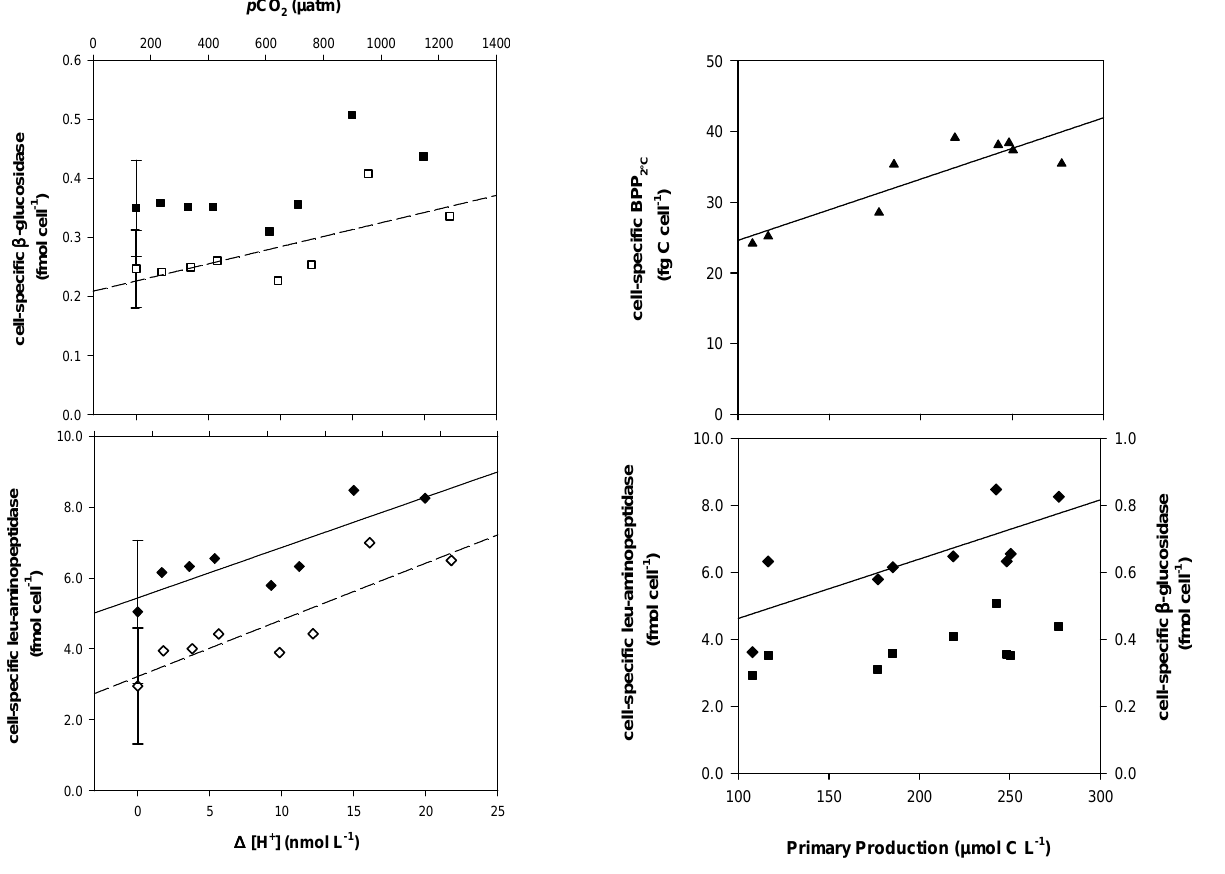
Fig. 11. Relationships between primary production and cell-specific bacterial protein production (BPP) (upper panel) and primary pro- duction and cell-specific extracellular enzyme activities (diamonds: leu-aminopeptidase, squares: β -glucosidase) (lower panel). All rates are time-integrated over the whole experiment. Lines repre- sent significant ( p < 0.05) linear regressions (BPP 2 ◦ C : r 2 = 0 . 77; leu-aminopeptidase: r 2 = 0 .